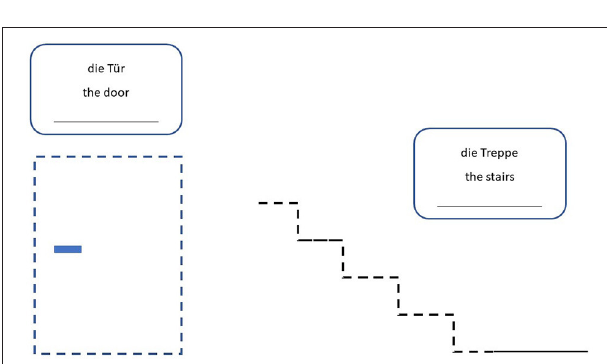
FIGURE 2 | Example of a worksheet: Inside the kindergarten. The children were encouraged to complete the